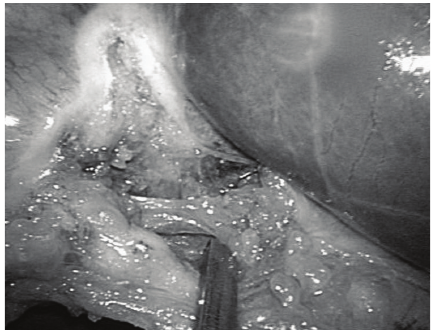
Figure 2: Articulating forcep used to retract Hartmann’s pouch to expose Calot’s triangle and critical view of safety is visualized.